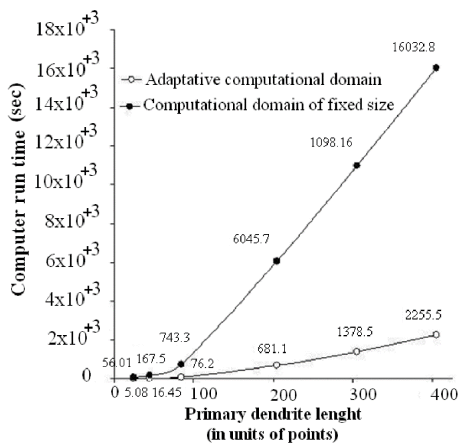
Figure 5. Variation of computer run time as a function of primary dendrite length, in units of points.